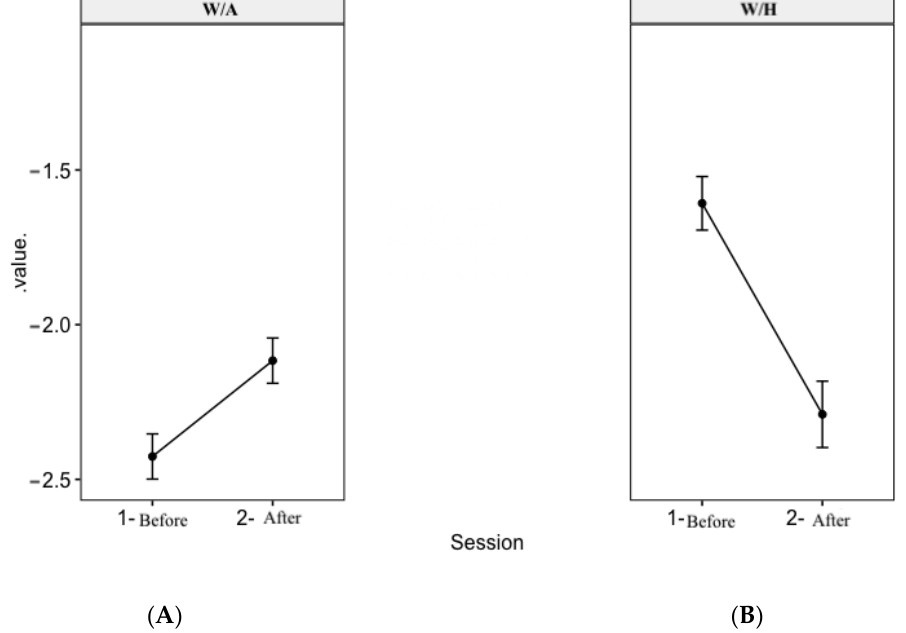
Figure 2. Changes in the ( A ) weight-for-age (W/A) and ( B ) weight-for-height (W/H) Z-scores of the MAM children before (day 1) and after (day 13) the LNR experimental sessions ( n = 289). Wilcoxon test.